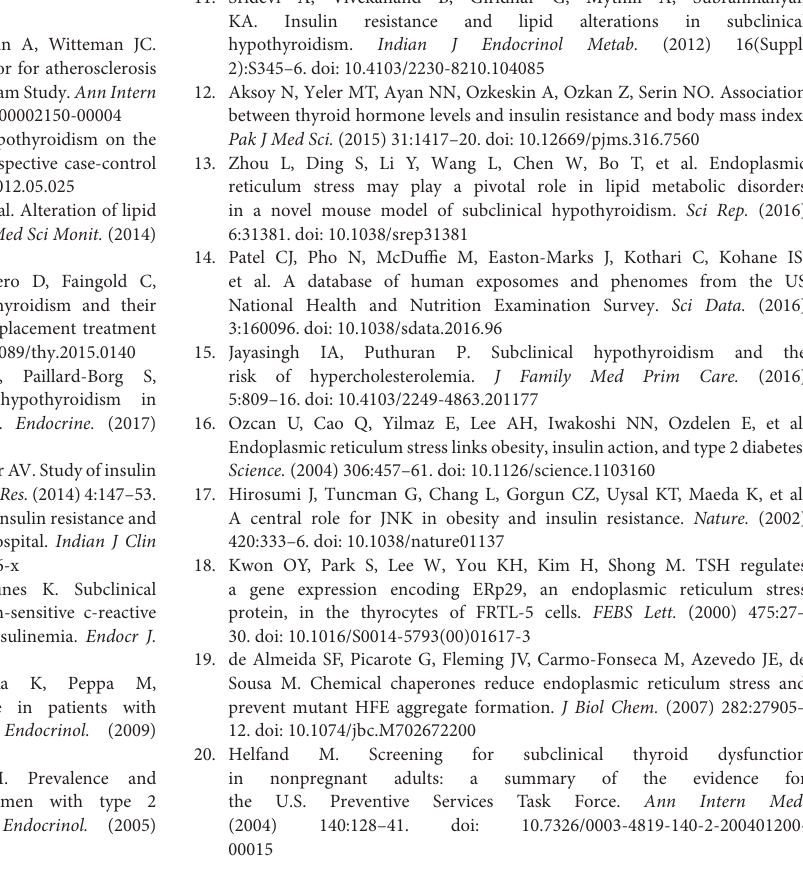
Supplementary Figure 1 | Study design and flow chart. Supplementary Figure 2 | Male C57/BL6 mice were given methimazole (MMI, 0.08 mg/kg · BW · d, SCH group) in drinking water or a corresponding volume of vehicle (control group) for 12 weeks. (A) The plasma TSH level was assayed at the 12th week ( n = 6). (B) The plasma FT4 level was assayed at the 12th week ( n = 6). The results are expressed as the mean ± SD. ∗ p < 0.05 compared with control. Supplementary Figure 3 | The expression of JNK in SCH mice. Male C57/BL6 mice were given methimazole (MMI, 0.08 mg/kg · BW · d, SCH group) or a corresponding volume of vehicle (control group) for 14 weeks, the expression of JNK were detected by western blot ( n = 4–6). ∗ p < 0.05 compared with control. Supplementary Figure 4 | We established SCH mouse model using MMI. When MMI was applied for 14 weeks, 4-PBA was given at a dose of 100 mg/kg · BW · d for 4 weeks, and mice were divided into four subgroups: vehicle treated control mice group (con + veh group), 4-PBA treated control mice group (con + 4-PBA group), vehicle treated SCH mice group (SCH + vehicle group), and 4-PBA treated SCH mice group (SCH + 4-PBA group). (A) The plasma TSH level was assayed at the 12th week ( n = 4–6). (B) The plasma FT4 level was assayed at the 12th week ( n = 4–6). The results are expressed as the mean ± SD. ∗ p < 0.05 compared with